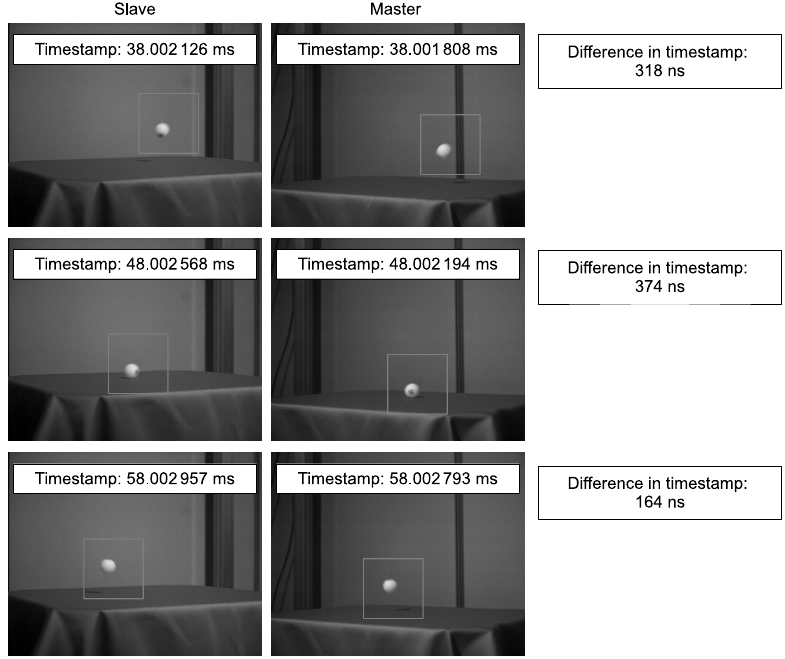
Figure 7. Some of the images acquired by the two vision sensor nodes. The left-hand images were acquired by the slave node, and the right-hand images were acquired by the master node. The images and the corresponding timestamps provided by the PCs are shown. The gray box in each frame represents the region of